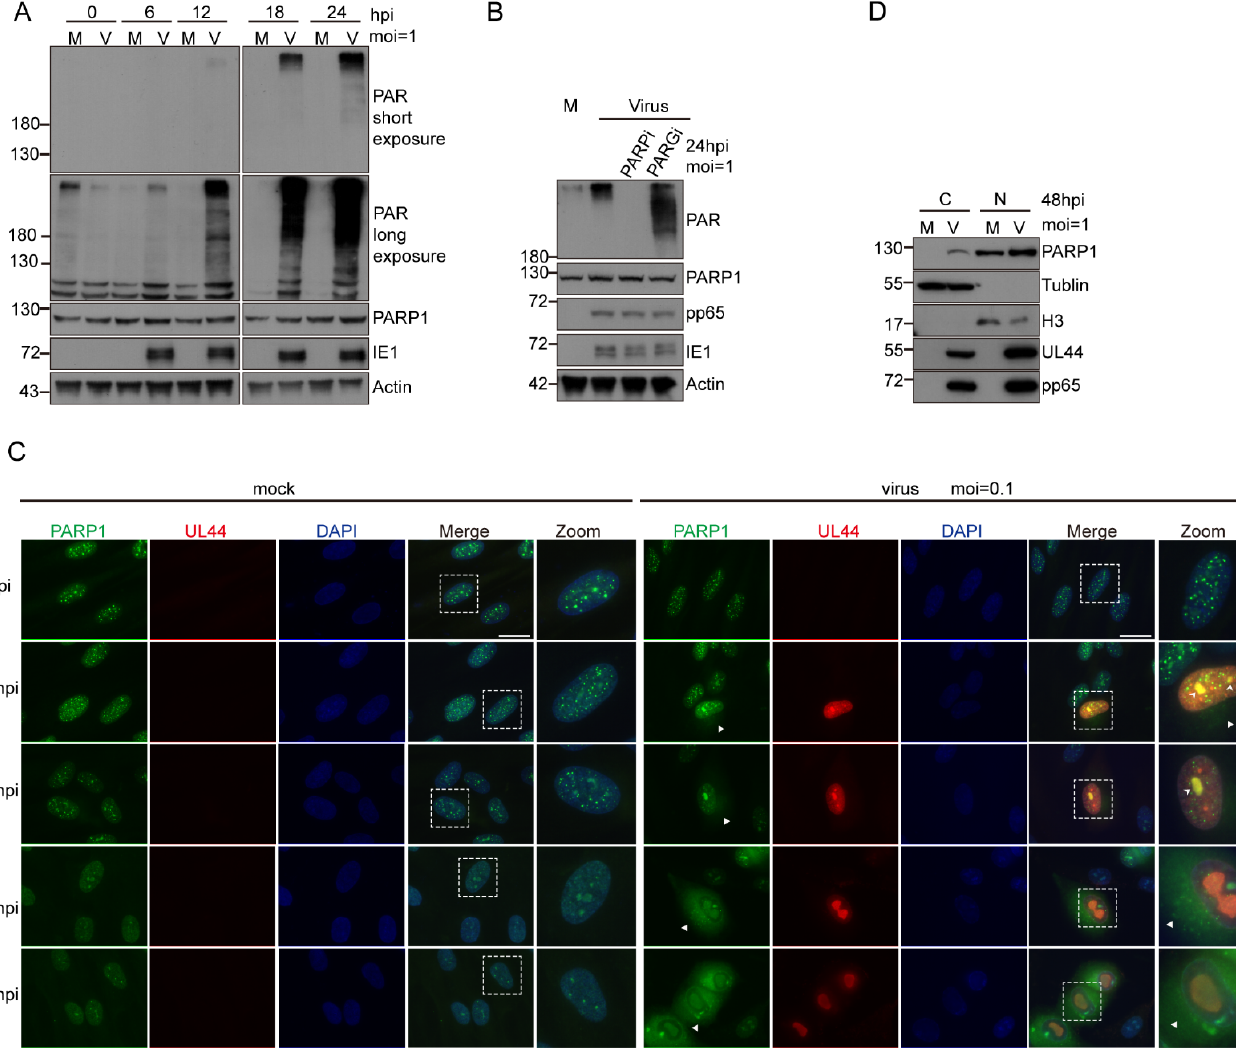
Figure 2. HCMV infection induced increase in protein PARylation and cytosolic translocation of PARP-1. ( A ) Analysis of protein PARylation levels at indicated times after HCMV infection. MRC-5 cells were mock infected (M) or infected (V) with HCMV (MOI = 1) and harvested at various times post-infection. Protein PARylation was detected by WB with PAR antibody. IE1 served as a marker for HCMV infection. ( B ) The increase in protein PARylation levels was due to PARP-1 activation. MRC-5 cells were infected with HCMV at an MOI of 1. After virus adsorption, small molecule inhibitor to PARP-1 (Olaparib 10 µM) or PARG (PDD 00017273 10 µM) was added to the medium. Cells were harvested at 24 hpi and protein PARylation levels were analyzed. ( C , D ) HCMV infection induced the cytosolic translocation of PARP-1 in MRC-5 cells. ( C ) MRC-5 cells were infected with HCMV at an MOI of 0.1 and fixed with cold methanol/acetone (1:1) at various times. Expression profiles and localization of PARP-1 and HCMV UL44 over the course of HCMV infection were examined by immunofluorescence assay. Triangles indicated the repositioned PARP-1 in cytoplasm. Arrowheads indicated the colocalization between PARP-1 and UL44. Zoomed pictures were also provided to show the cytoplasmic translocation of PARP-1. Scale bar, 20 µm. ( D ) Immunoblotting of indicated proteins in the cytoplasmic and nuclear fractions of MRC-5 cells infected (V) or mock infected (M) with HCMV at an MOI of 1 for 48 h. “C” refers to cytoplasmic and “N” refers to nuclear.